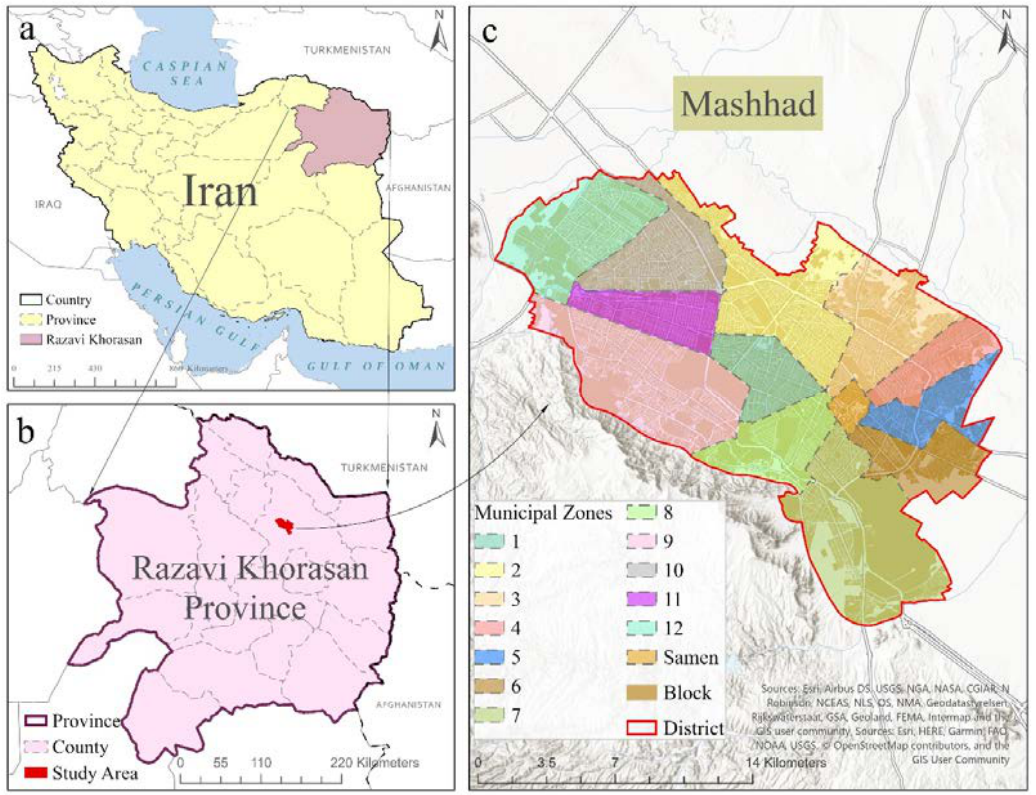
Fig. 1: Map of the study area. (a) Iran, (b) Razavi Khorasan province, (c)